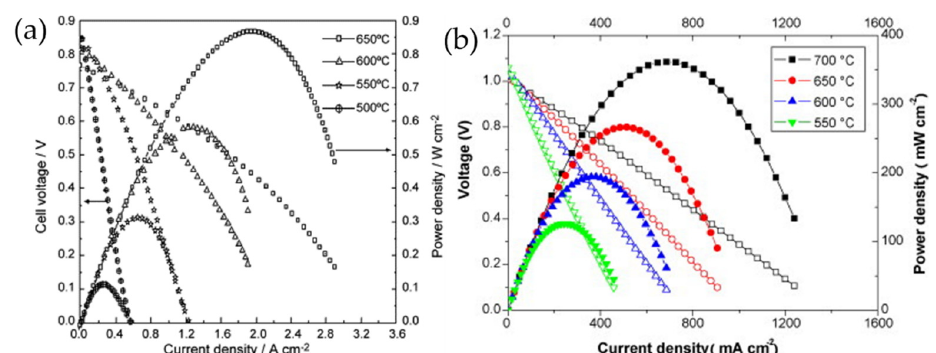
Figure 5. Performances of the cell with PrBaCo 2 O 5+ δ cathode and ( a ) oxygen-ion-conducting Ce 0.8 Sm 0.2 O 1.9 electrolyte (reproduced with permission from [69]. Copyright 2008, Elsevier) and ( b ) proton-conducting BaCe 0.5 Zr 0.3 Y 0.16 Zn 0.04 O 3– δ electrolyte (reproduced with permission from [98]. Copyright 2010,